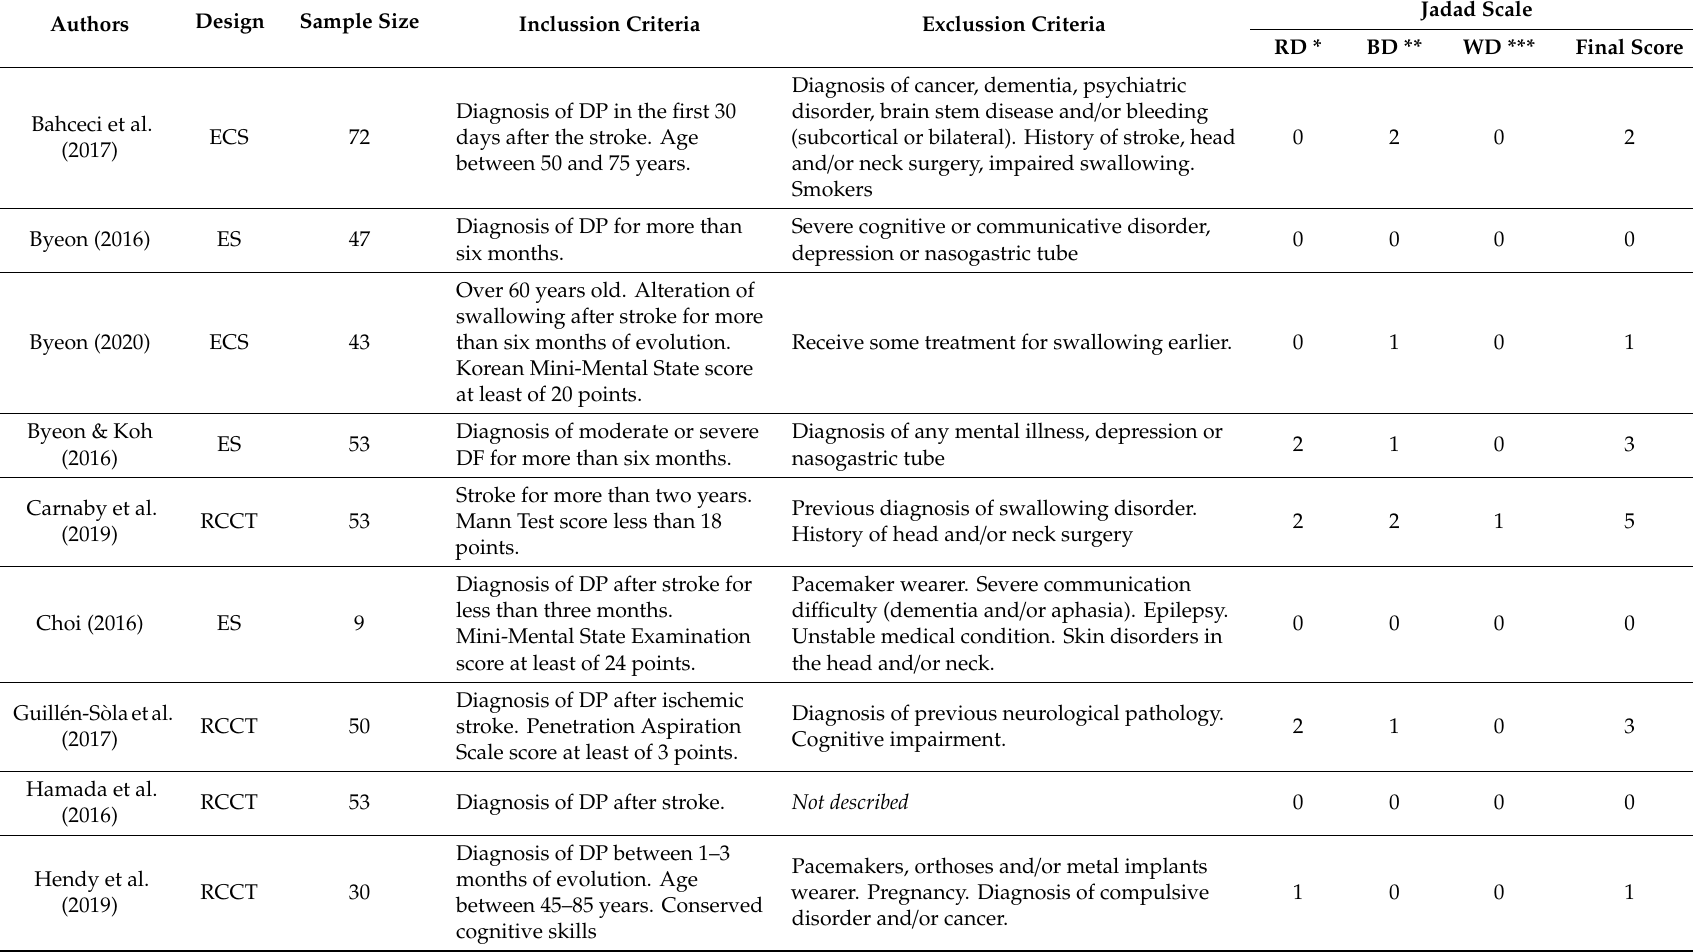
Table 2. Methodological characteristics of the studies